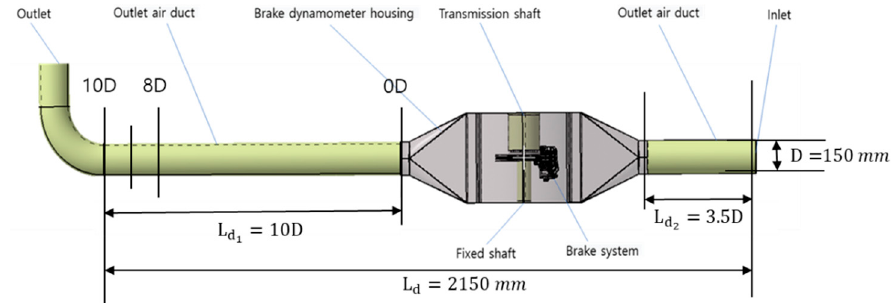
Figure 1. A 3D model of the brake dust dynamometer with an enclosure system.